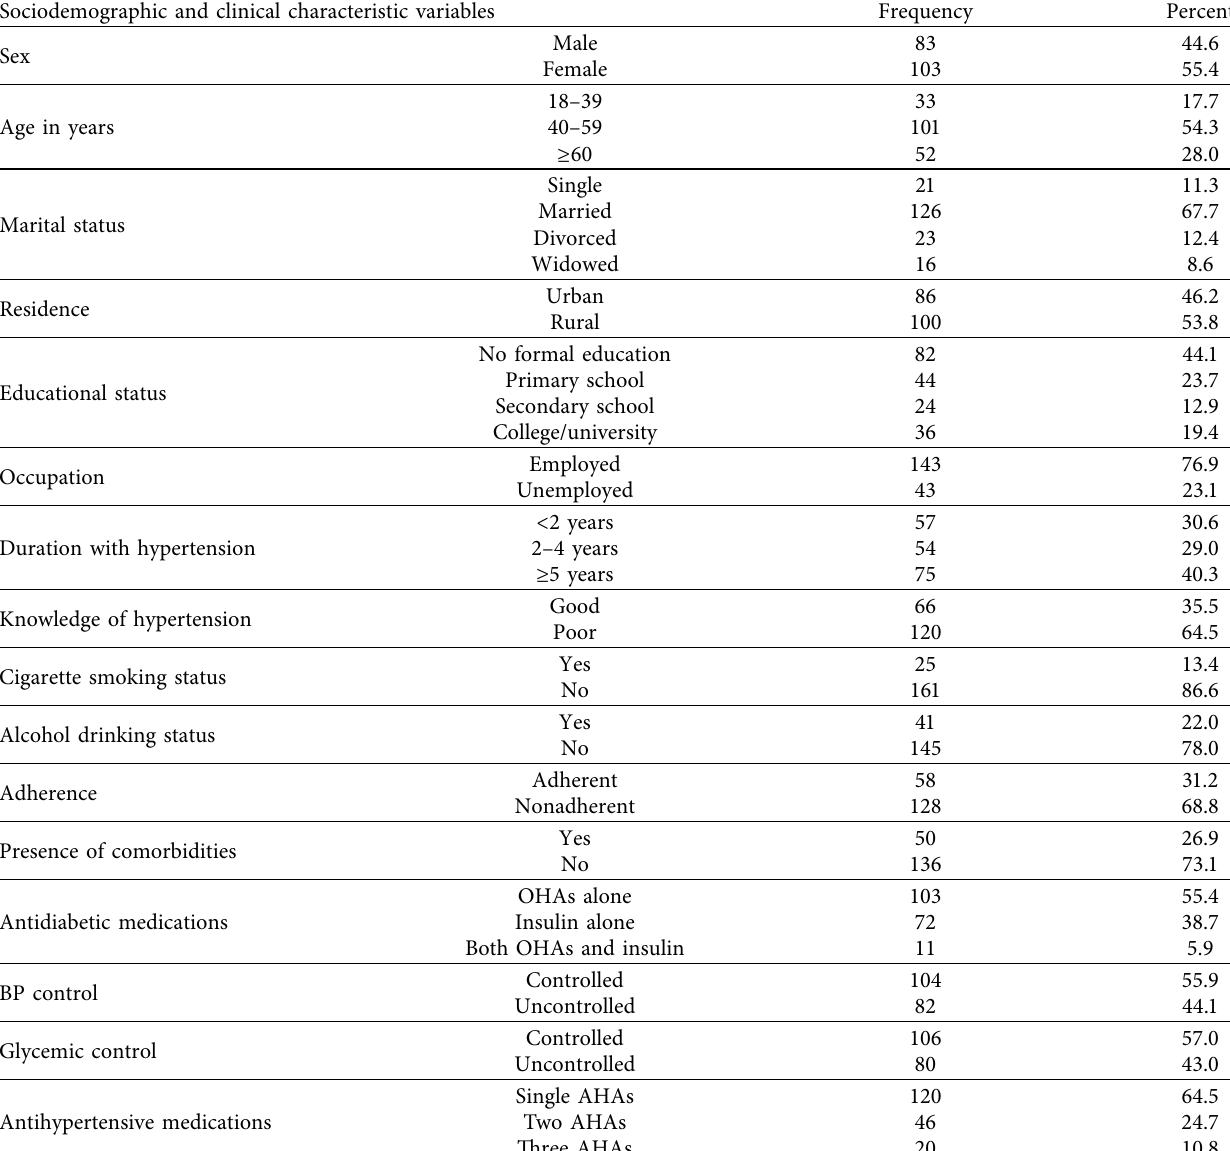
Table 1: Sociodemographic and clinical characteristics of hypertensive diabetic patients on follow-up at NRH, West Ethiopia, 2018 ( n �